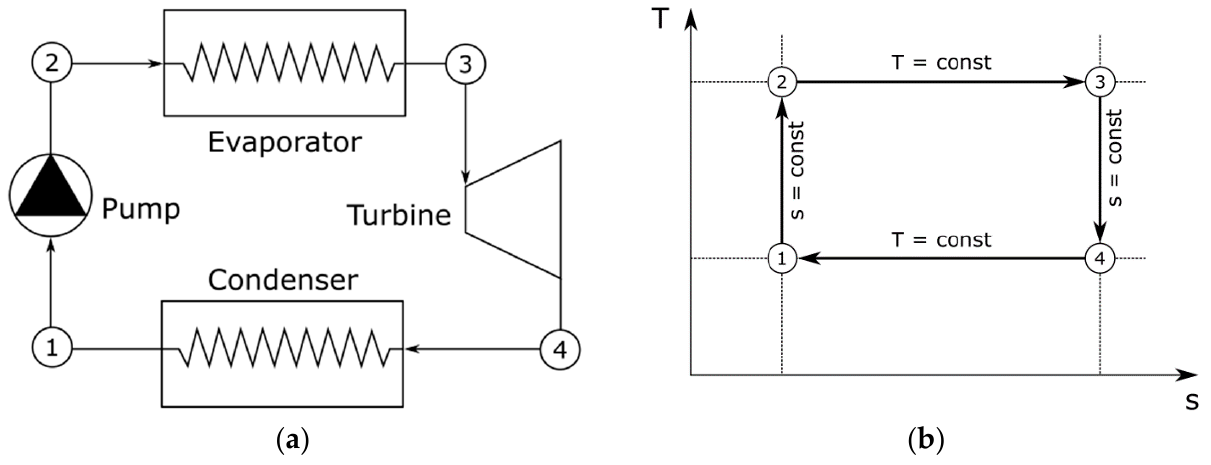
Figure 3. ( a ) Equipment and ( b ) T-s diagram of the Carnot cycle.